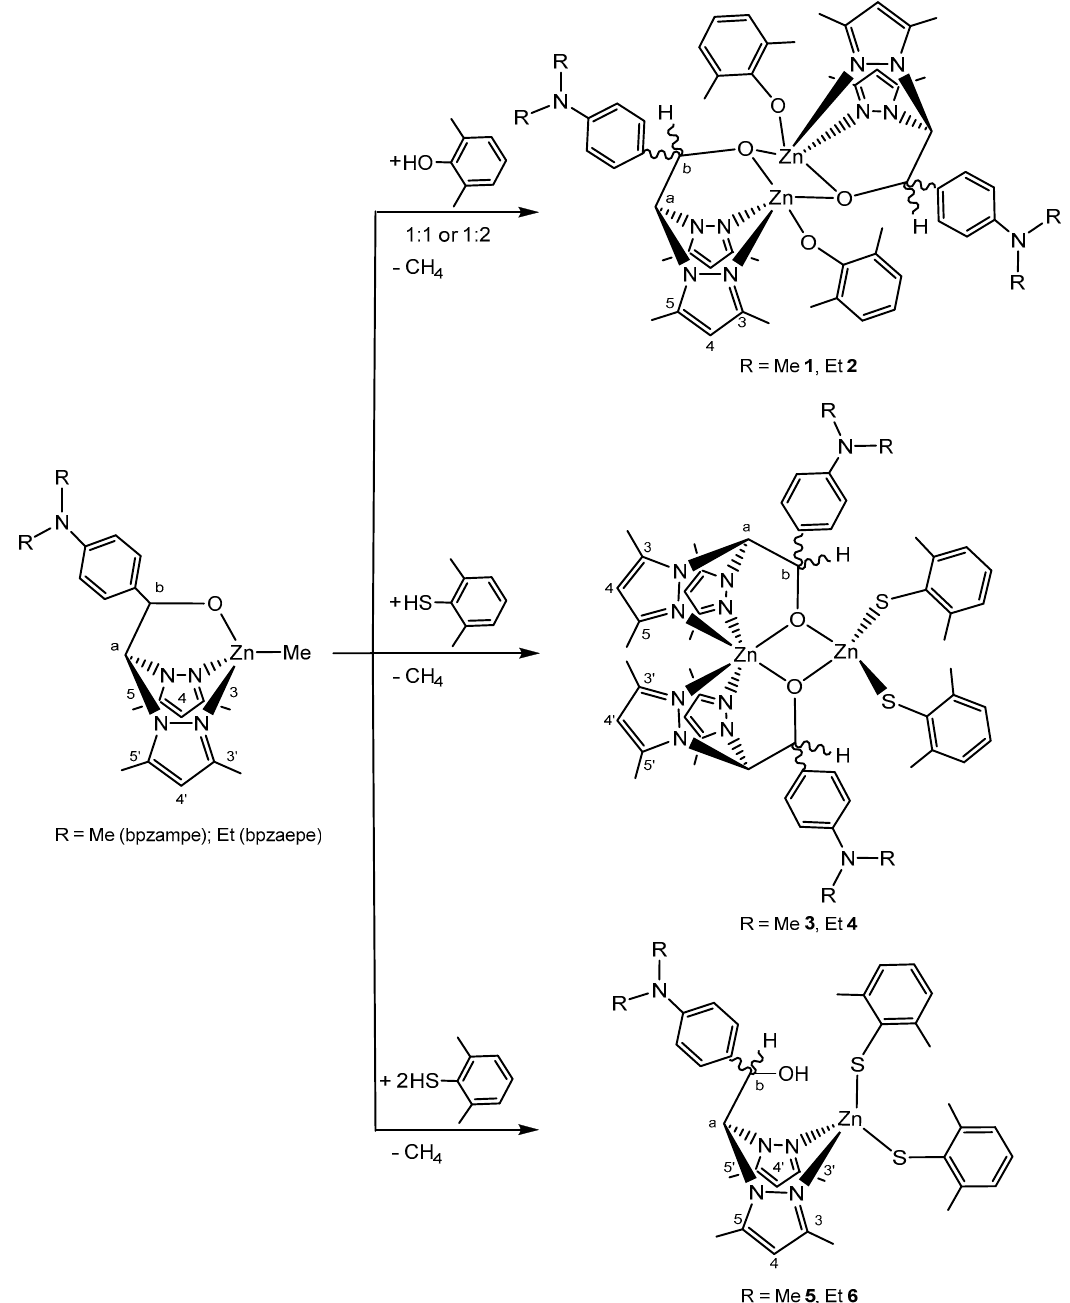
details are reported in Table S1. Only one diastereoisomer, namely “rac”, was present in the unit cell. These studies confirmed that the presence in solution of only one diastereoisomer for these compounds is maintained in the solid state. The complexes have a dinuclear structure with two μ - bridging alkoxide groups from the scorpionate ligands between the two six- and four-coordinate Zn(II) atoms. The first zinc centre Zn(1) has a distorted octahedral geometry with a heteroscorpionate ligand that acts in a tridentate fashion. The pyrazolic nitrogens N(1), N(3), N(6) and N(8) occupy four positions and the alkoxide oxygen-bridging μ -O(1) and μ -O(2) occupy the other two positions.